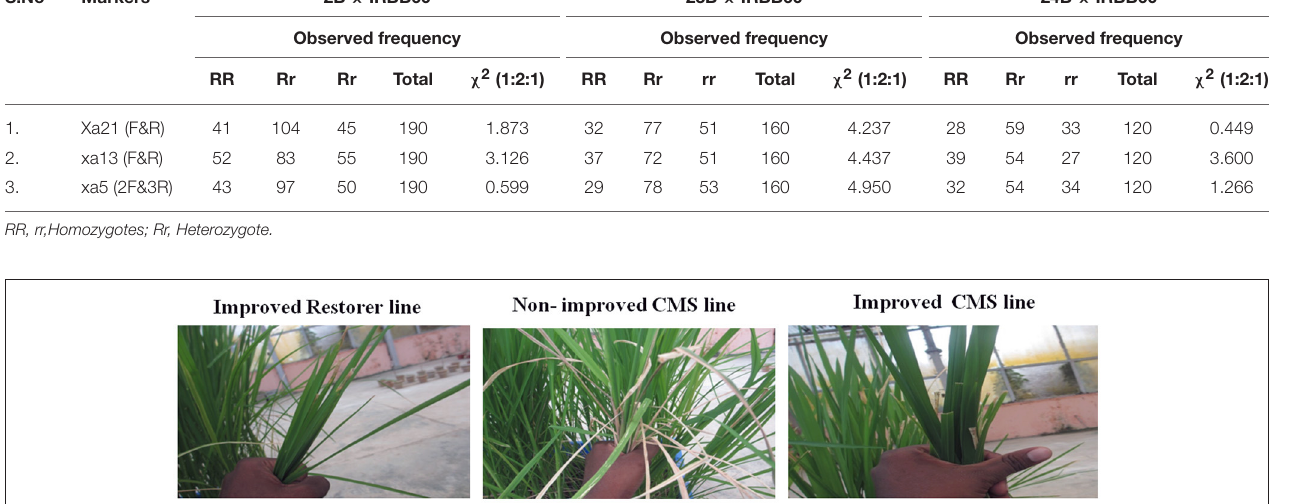
TABLE 2 | Segregating ratio of the marker genotypes in BC 2 F 2 generation for BB. S.No Markers 2B × IRBB60 23B × IRBB60 24B × IRBB60 Observed frequency Observed frequency Observed frequency RR Rr Rr Total